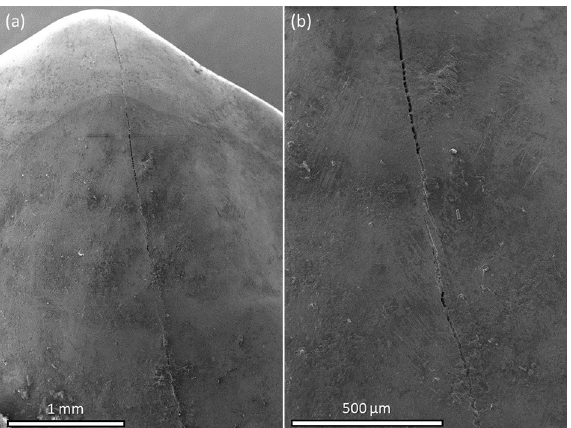
Figure 1. An example of SEM micrographs of EMCs on the buccal enamel surface: ( a ) the occlusal and ( b ) the middle part of the tooth